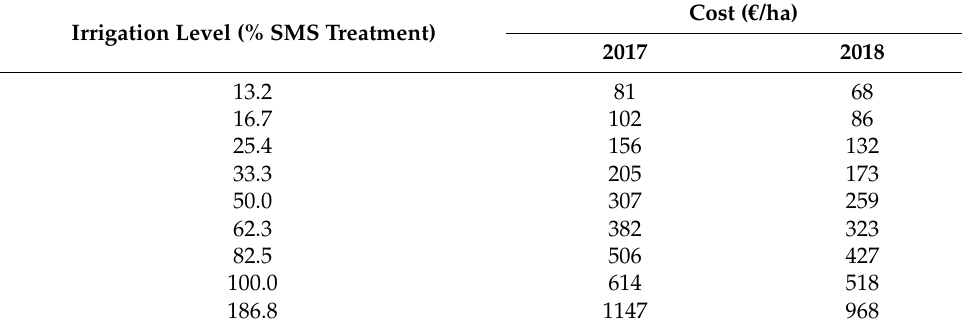
Table 2. Variable costs of irrigation water in different irrigation treatments. Irrigation Level (% SMS